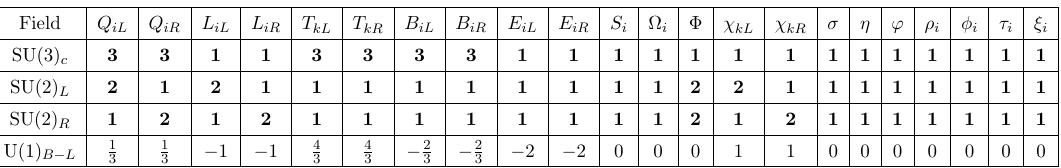
SU(2) L SU(2) R (cid:10) (cid:10) (cid:10)